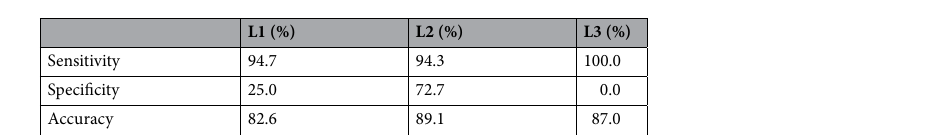
Table 2. Cross-validation performance between 3 learning indices and the prediction model of ECRS’s alpha frequency